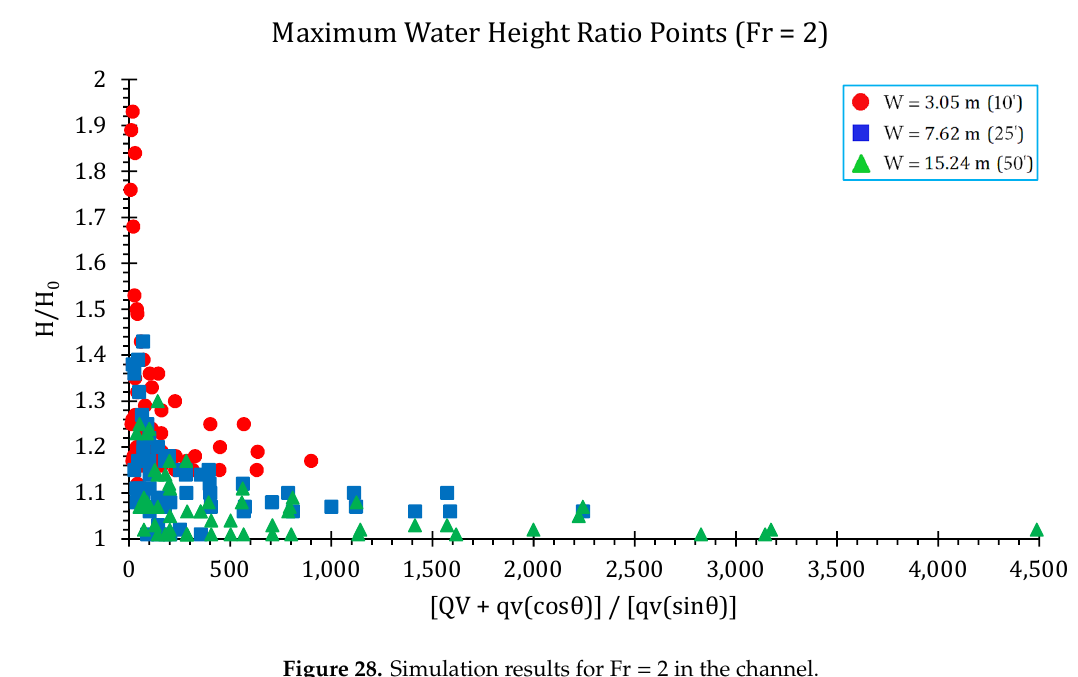
Figure 27. Splashing on the outer wall of a channel with super-critical flow and 90° junction angle.